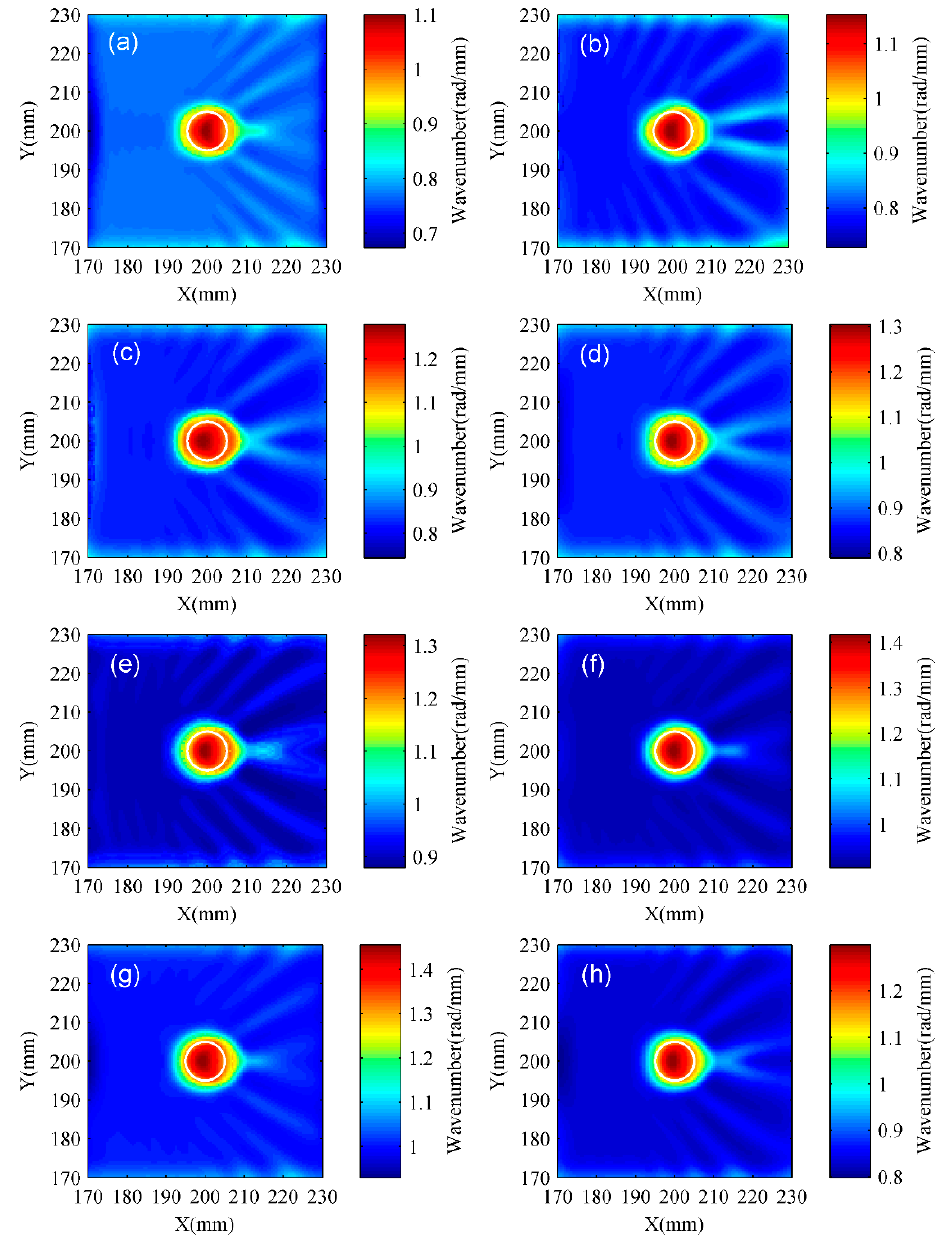
Figure 8. The acquisition of average wavenumber for Case 1. ( a ) Wavenumber distribution obtained at f = 155 kHz; ( b ) wavenumber distribution obtained at f = 170 kHz; ( c ) wavenumber distribution obtained at f = 185 kHz; ( d ) wavenumber distribution obtained at f = 200 kHz; ( e ) wavenumber distribution obtained at f = 215 kHz; ( f ) wavenumber distribution obtained at f = 230 kHz; ( g ) wavenumber distribution obtained at f = 245 kHz; ( h ) average wavenumber distribution.